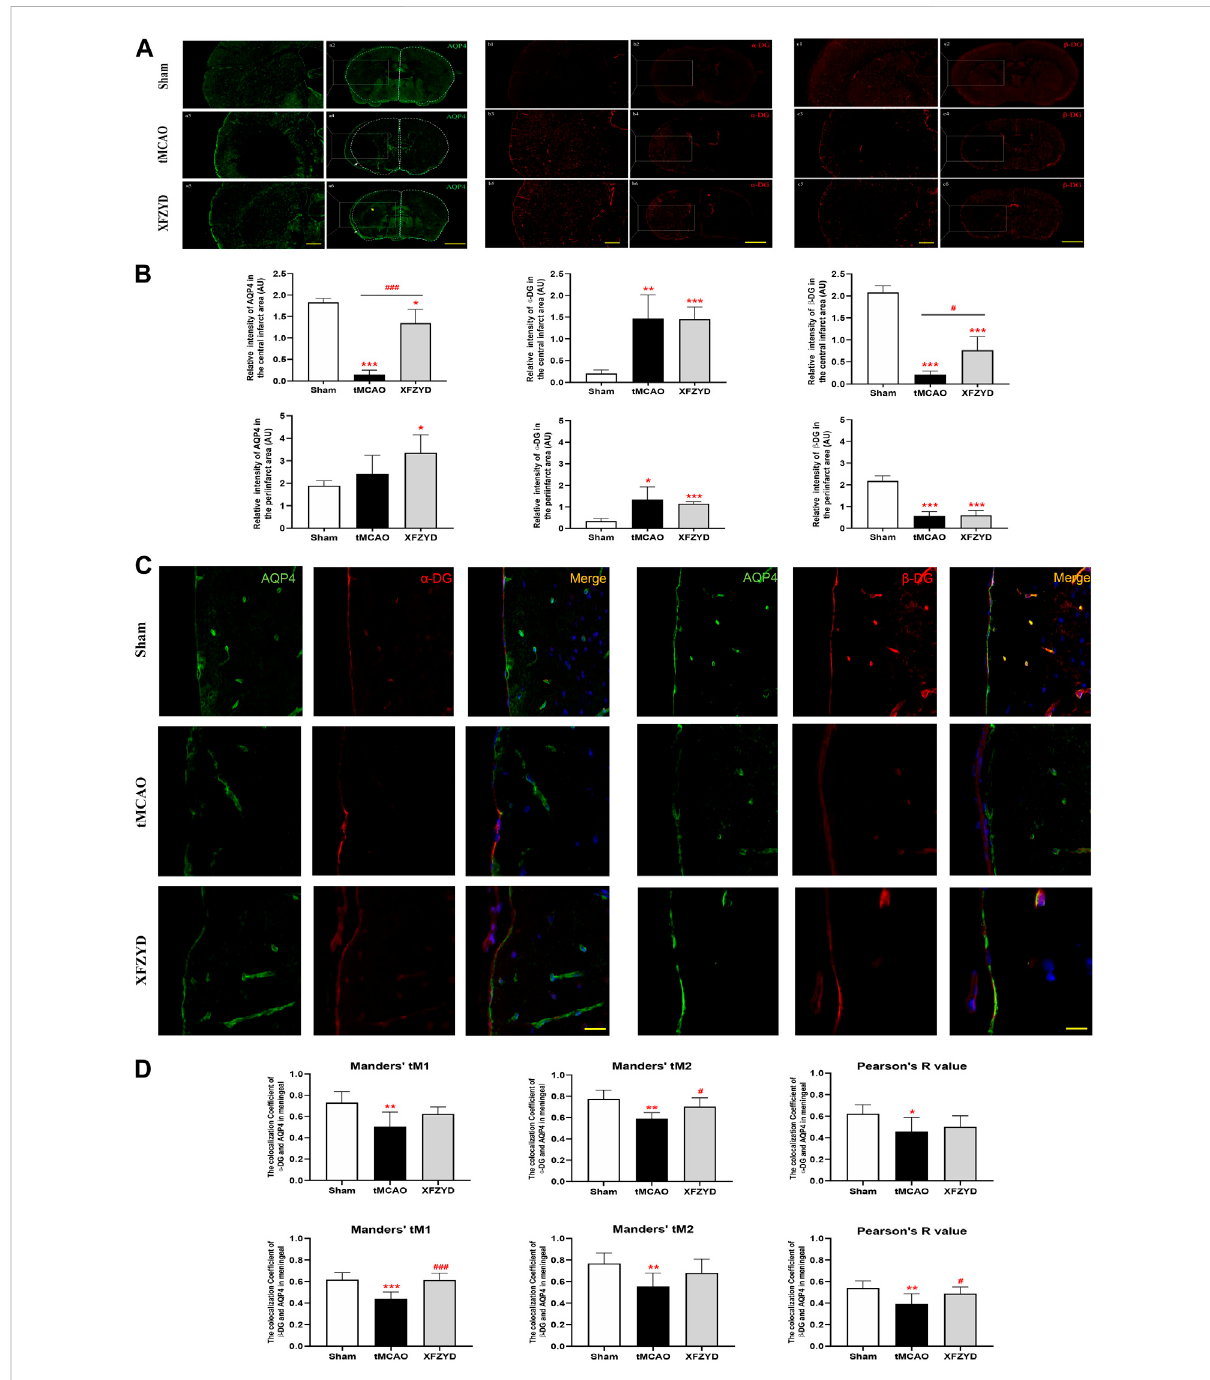
FIGURE 5 The effects of tMCAO and XFZYD on the colocalization of AQP4, α -DG and β -DG. (A) The immunostaining of AQP4, α -DG and β -DG in the infarctandperiinfarct areas(Scalebars,200 μ mand500 μ m). (B) QuantitativeanalysisofdataAininfarctareaandperiinfarct area. (C) Representative colocalizationimagesofAQP4, α -DGand β -DGimmunostaininginthemeningeal( α -DG,left; β -DG,right,Scalebar,10 μ m). (D) Quanti fi cationofthe colocalization of AQP4, α -DG and β -DG by Manders ’ tM1, Manders ’ tM2 and Pearson ’ s R value in different groups. (* p < 0.05, ** p < 0.01, *** p < 0.001 vs. the sham group, # p < 0.05, ### p < 0.001 vs. the tMCAO group; Data represent mean ± SD, n =